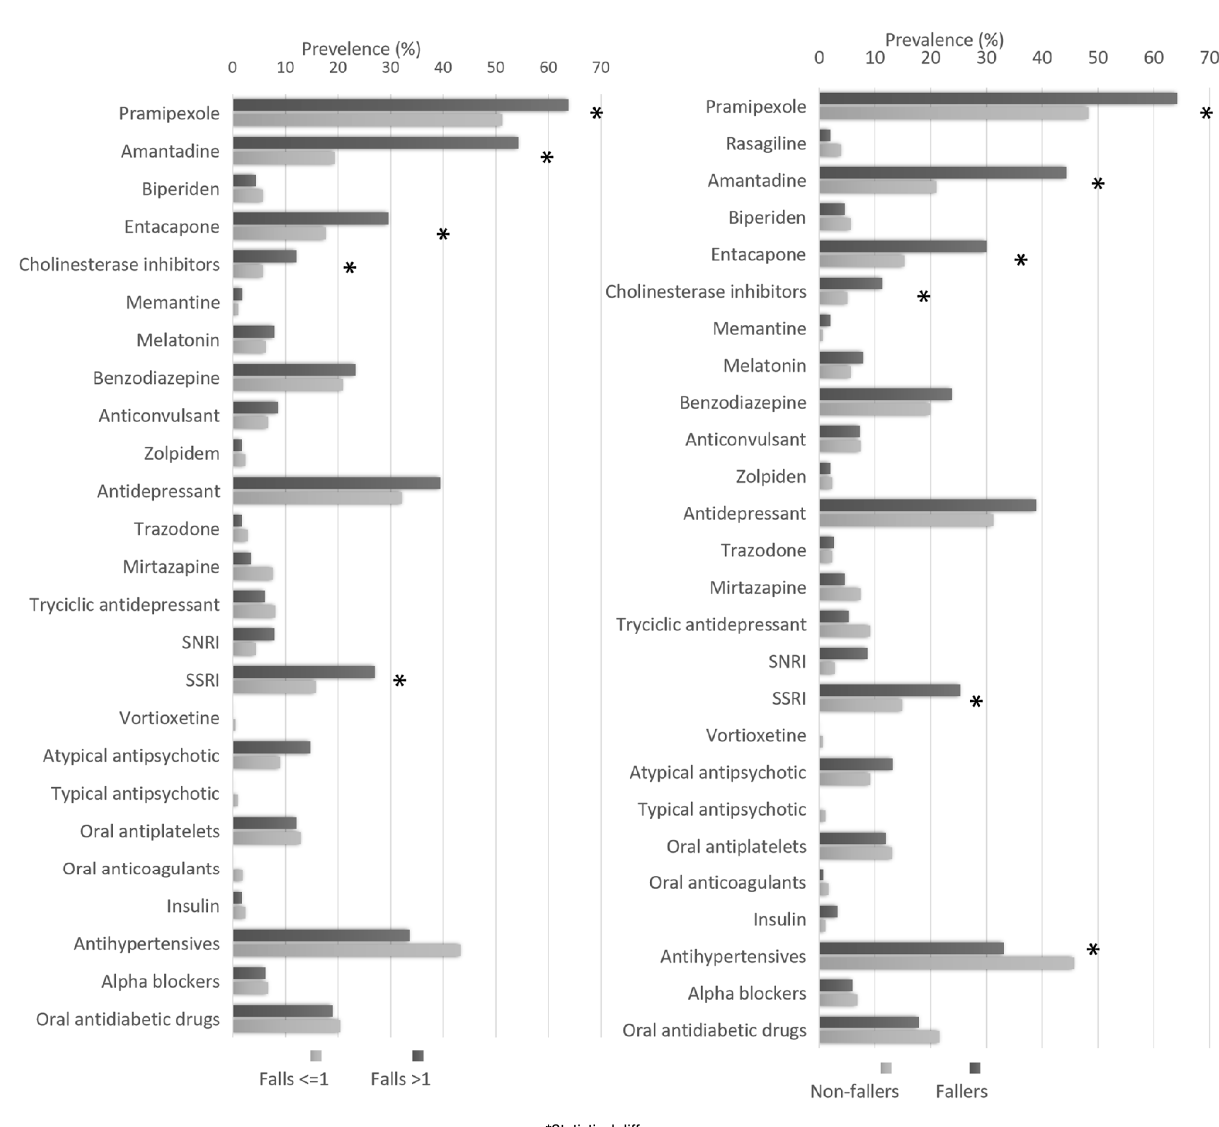
*Statistical difference. Figure 1. Frequency between fallers and medication